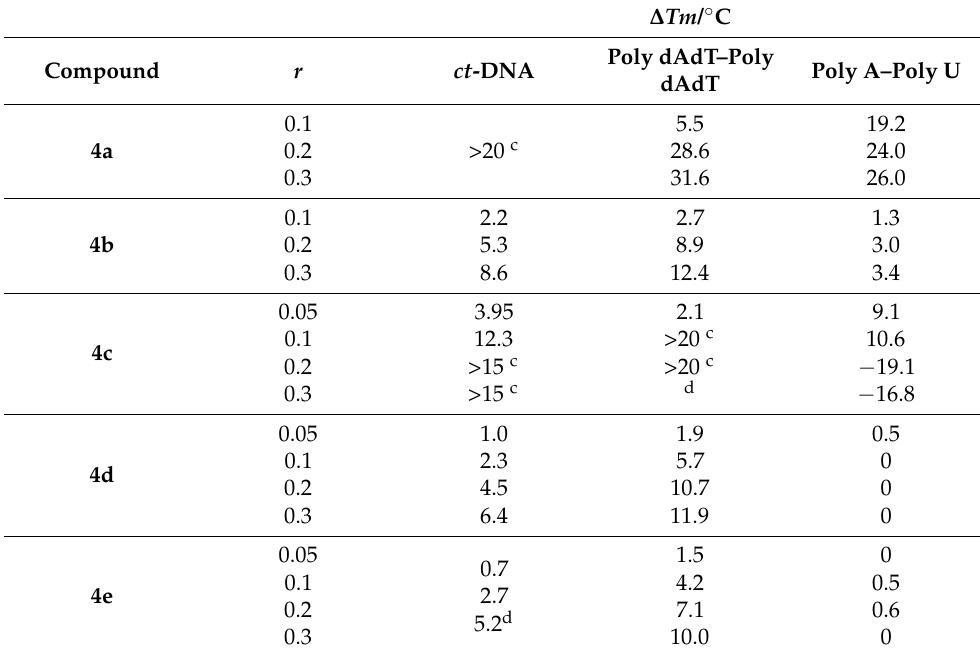
Table 1. The a ∆ T m values ( ◦ C) of the studied ds-polynucleotides upon addition of different ratios b r of 4a – 4e at pH = 7.0 (buffer sodium cacodylate, I = 0.05 mol dm − 3 ); c (polynucleotide) = 1–2 × 10 − 5 mol dm − 3